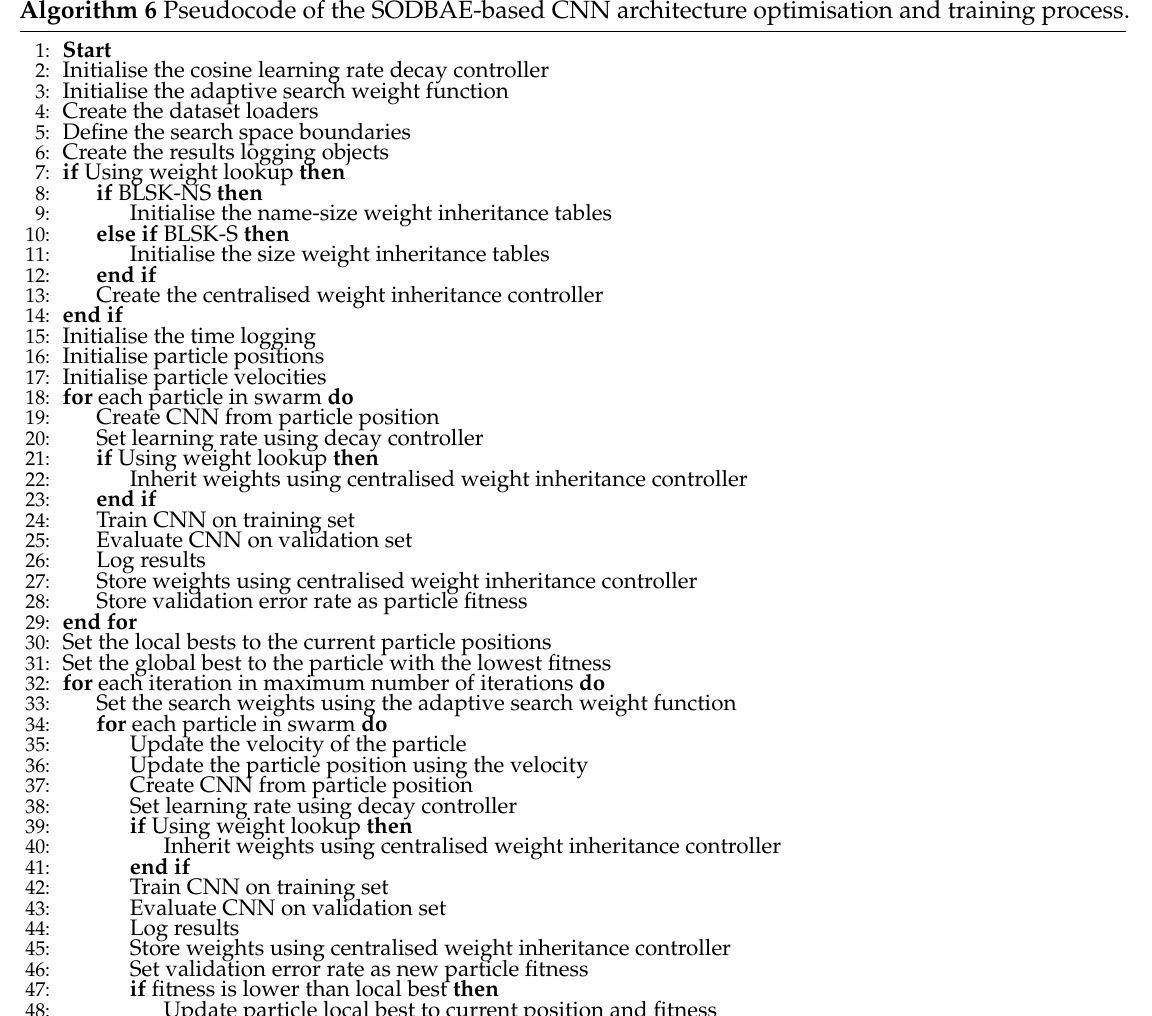
Algorithm 6 Pseudocode of the SODBAE-based CNN architecture optimisation and training